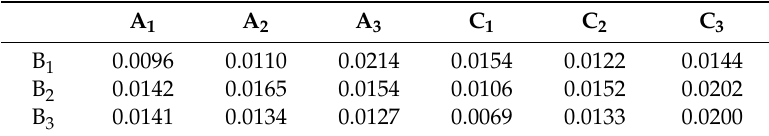
Table 7. Two-way factorial table based on levels in Table